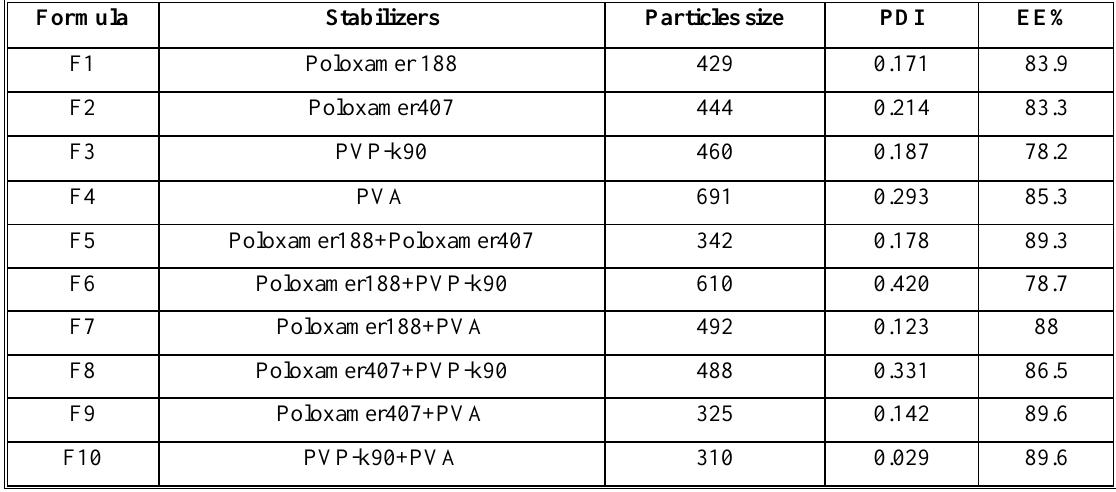
Table 4. Particle Size , PDI and EE% of formulas at drug: stabilizer ratio 1:1.